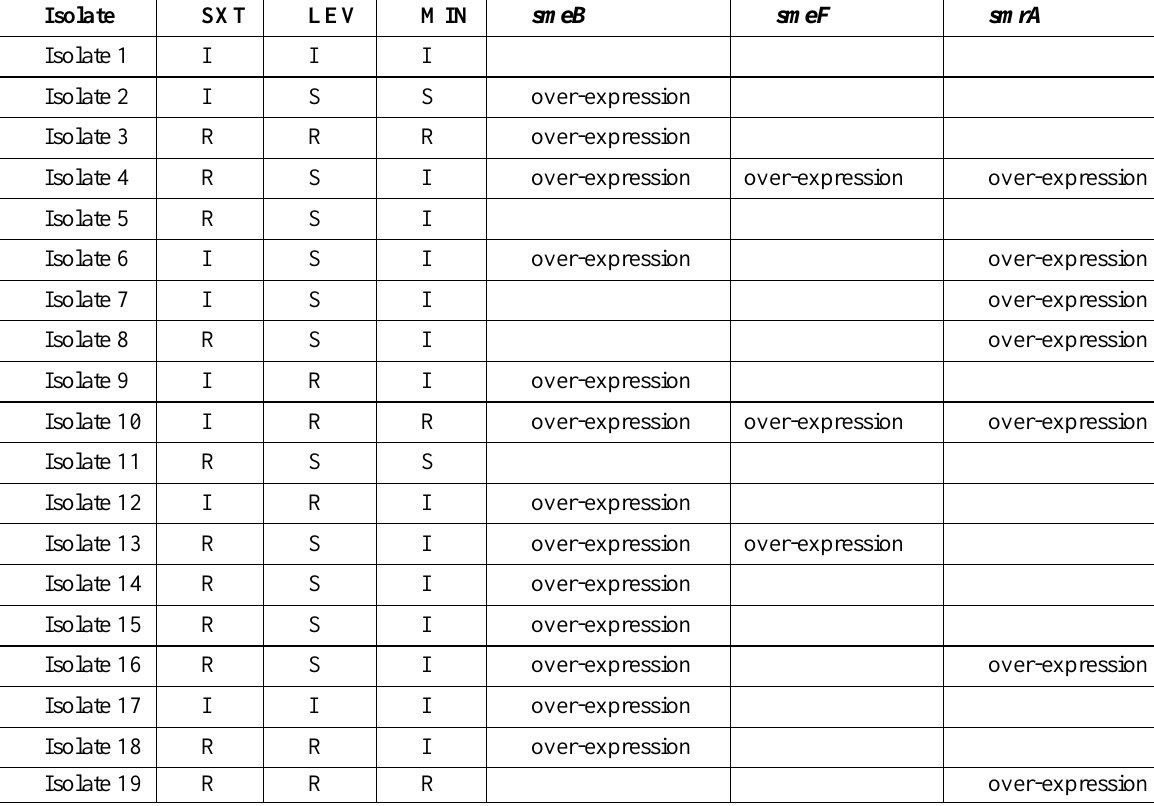
Table 4. The distribution of the over-expression of smeB , smeF among the different isolates along with their susceptibility patterns.